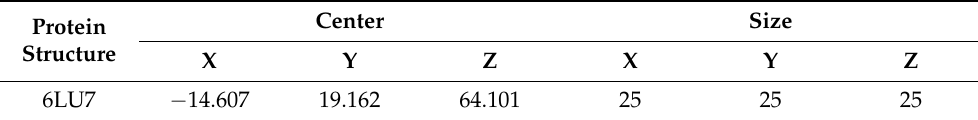
Table 1. The coordinates and the size of the grid box on 6LU7 crystal structure. Center Size Protein Structure X Y